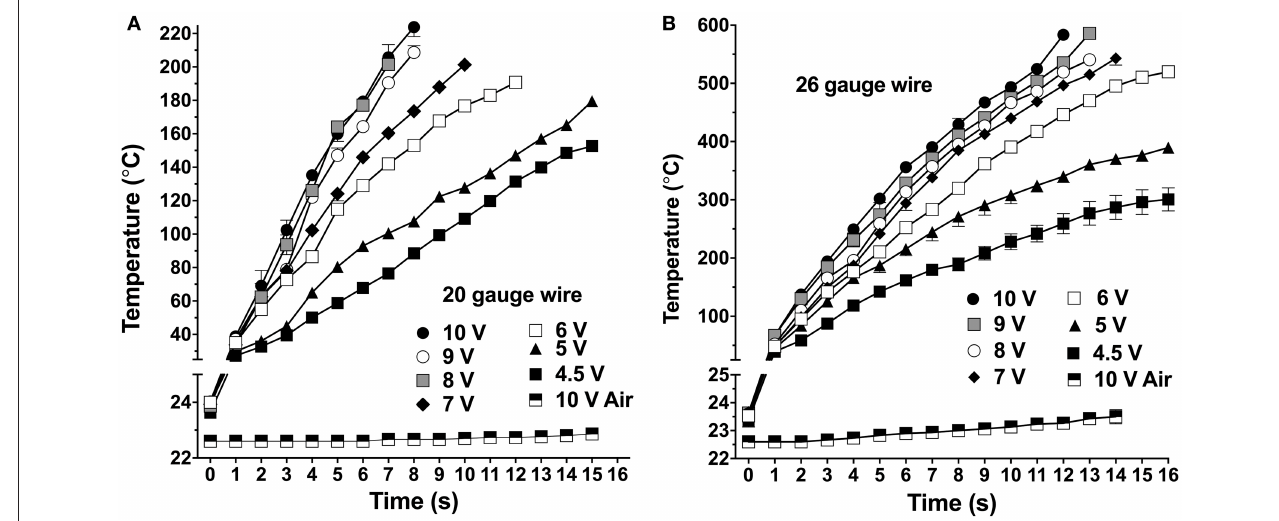
FIGURE 2 | Temperature changes in two gauges of wire at different applied voltages. (A) 20-gauge wire. (B) 26-gauge wire. Air delivery temperature at the mouth of the application pipette was measured using the highest induction heating voltage, designated “10V Air” in both plots. Symbols are mean ± SEM; symbols apparently lacking error bars is because they are within the size of the